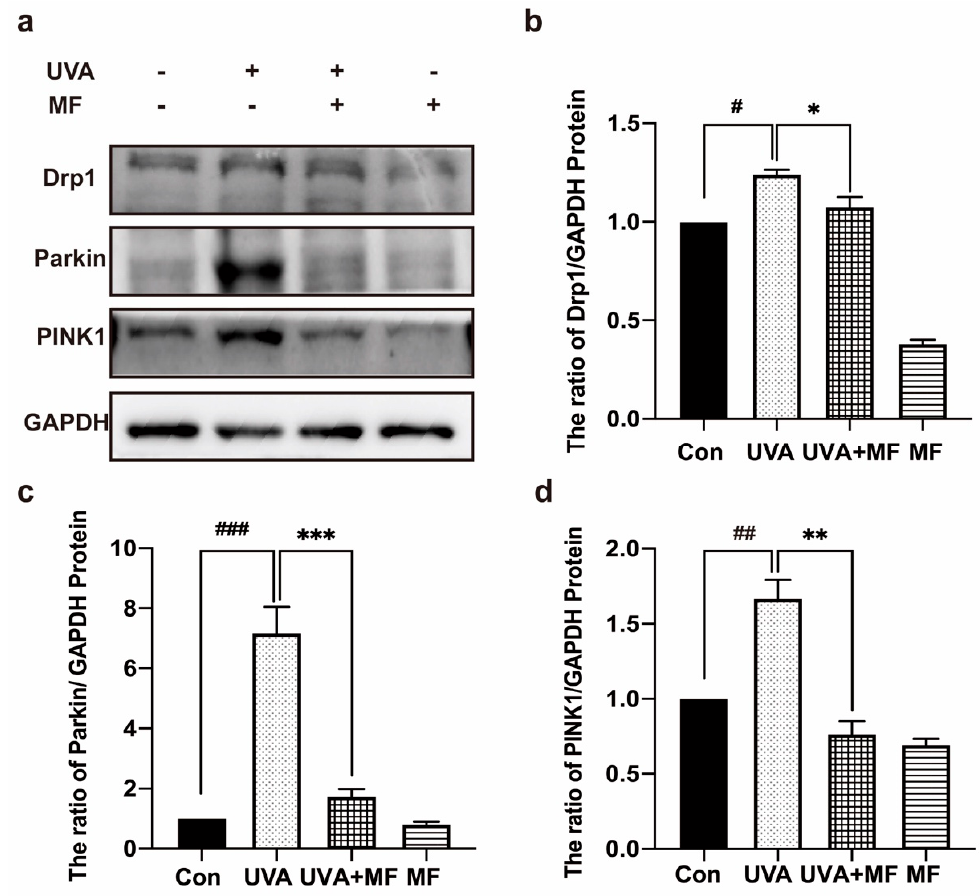
Figure 5. Metformin reduces UVA-induced mitophagy in HFFs. ( a – d ) Cells were treated with UVA alone or in combination with 100 μ M metformin. The protein levels of Drp1, PINK1, Parkin were measured by western blot. Data are presented as mean ± SD, n = 3. # p < 0.05, ## p < 0.01, ### p < 0.001 vs. control cells, * p < 0.05, ** p < 0.01, *** p < 0.001 vs. UVA ‐ treated cells.